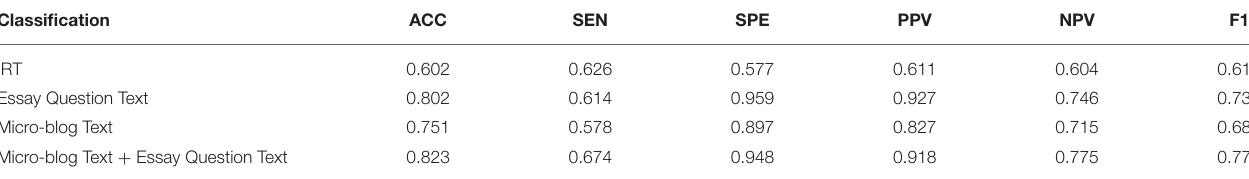
TABLE 5 | The results of the four models in IRT classification and text classification. Classification